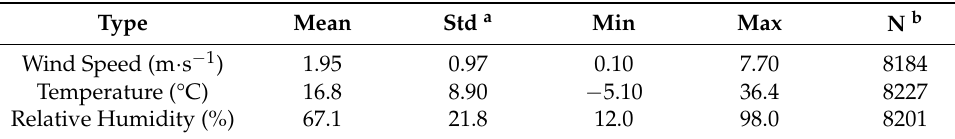
Table 1. The mean values of the different meteorological variables. Type Mean Std a Min Max N b Wind Speed (m · s − 1 ) 1.95 0.97 0.10 Temperature (°C) 16.8 8.90 Relative Humidity (%) 67.1 21.8